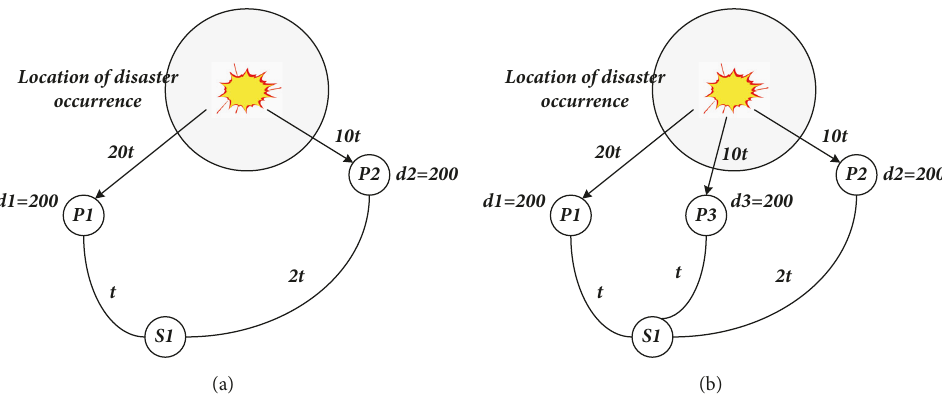
Figure 6: Illustration of evacuation scenarios: (a) one-shelter two-pick-up locations; (b) one-shelter three-pick-up locations.